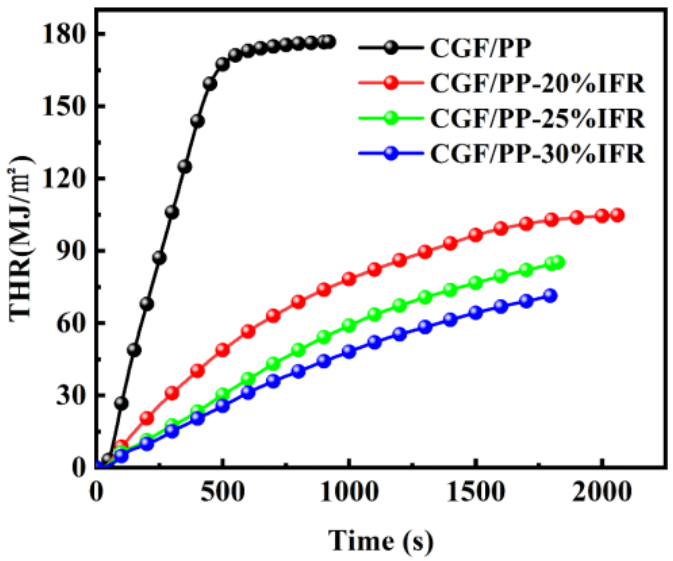
Figure 6. Total heat release rate curves of composites with different IFR content.